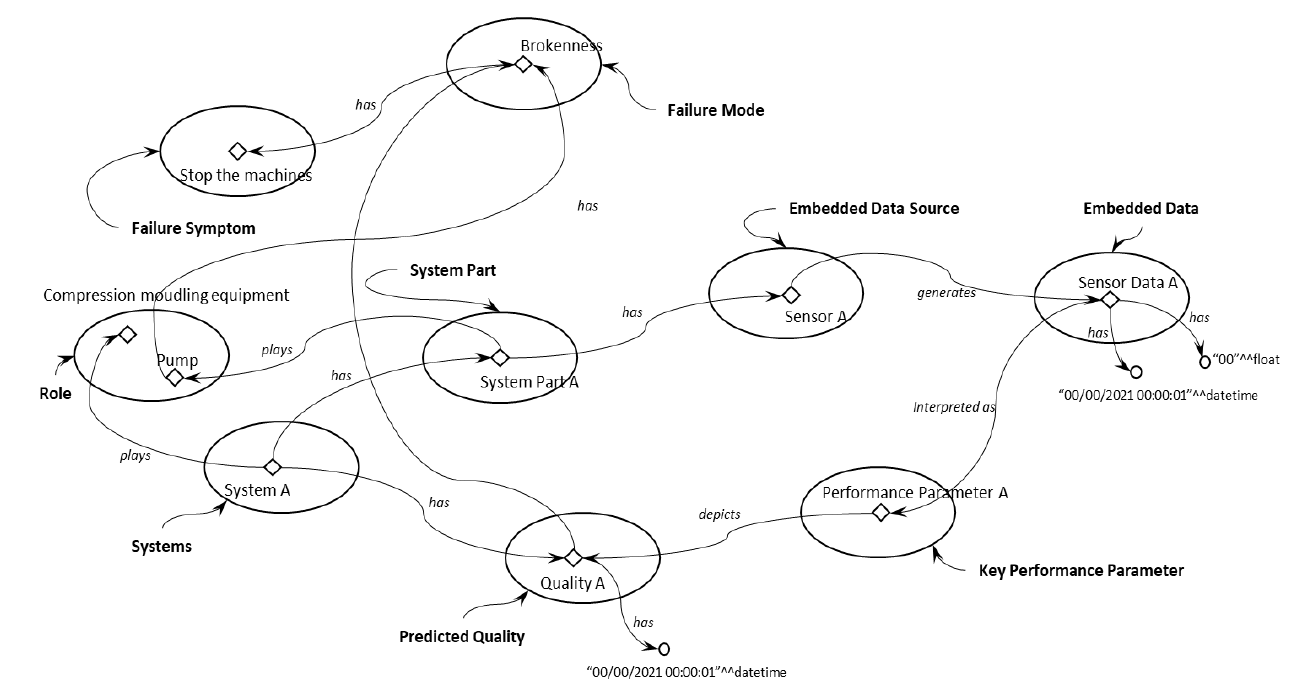
Figure 5. Structure of the compression molding machine.